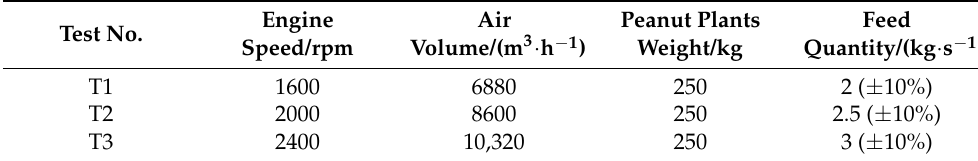
Table 2. Settings of test parameters.